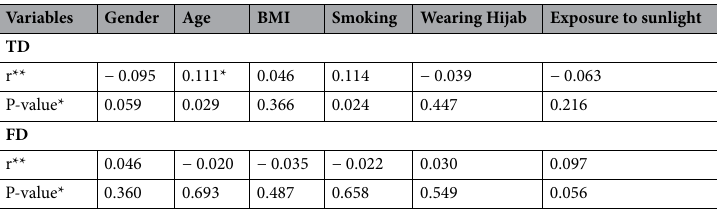
Table 10. Spearman’s correlations relations between Total 25-OHD and Free 25-OHD with different variables. *Correlation is significant at ≤ 0.05 level (2-tailed). **Spearman Correlation.